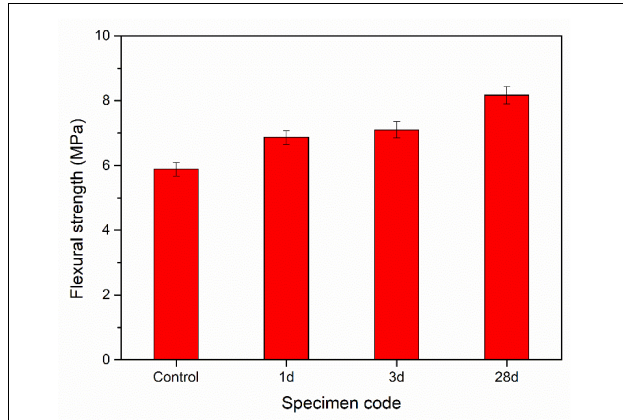
FIGURE 13 | Flexural strength of plain concrete beam and concrete beam repaired with CSA-ECC for different age.